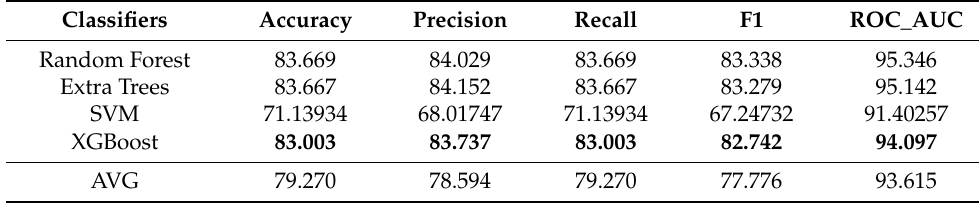
Table 8. Experimental Results using S1HT1 with 166 features.